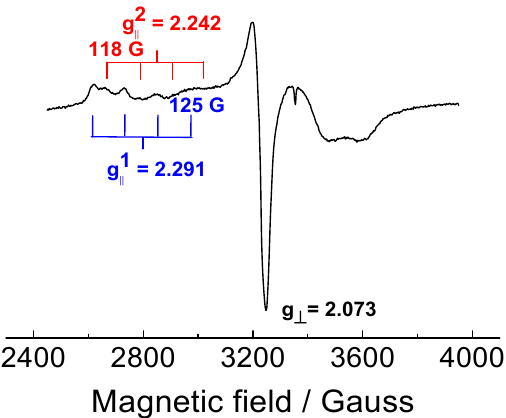
Figure 2. EPR spectrum of in DMSO solution at 110 K. Concentration of Cu was 1 mM. Table 1. EPR data of Cu–kaempferol complex (1:1) in DMSO at 100 K.